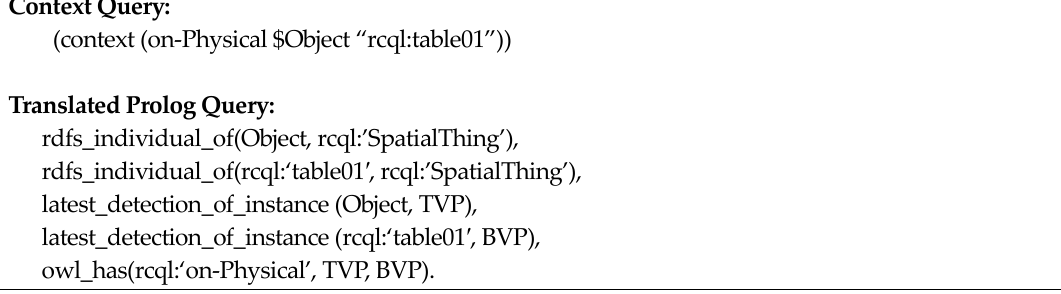
Figure 13. Illustration of translation for simple spatial query pattern. BVP is the visual perceptions of base object ( table01 ) and TVP is the visual perceptions of target objects (not include table01 ).